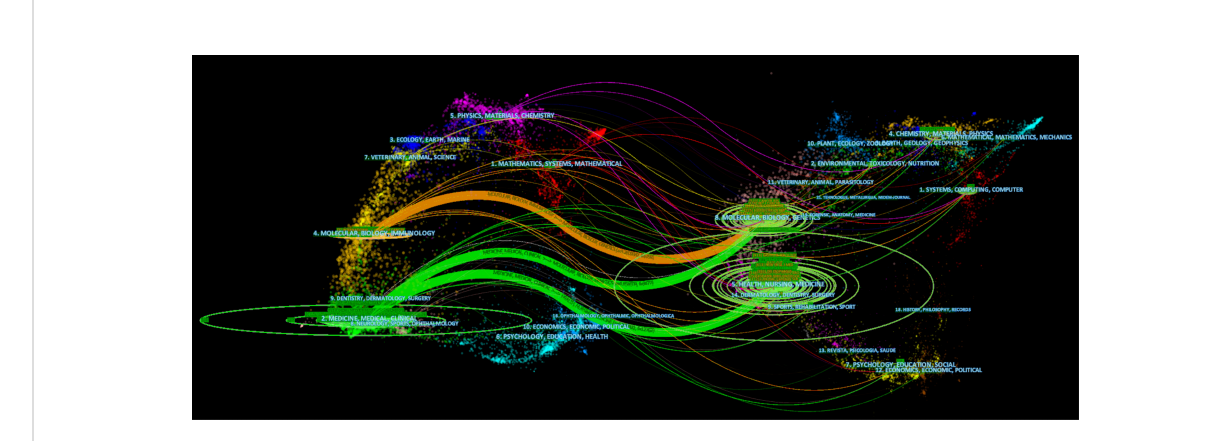
FIGURE 4 A dual-map overlap of journals on AI research in EC carried out by Citespace.